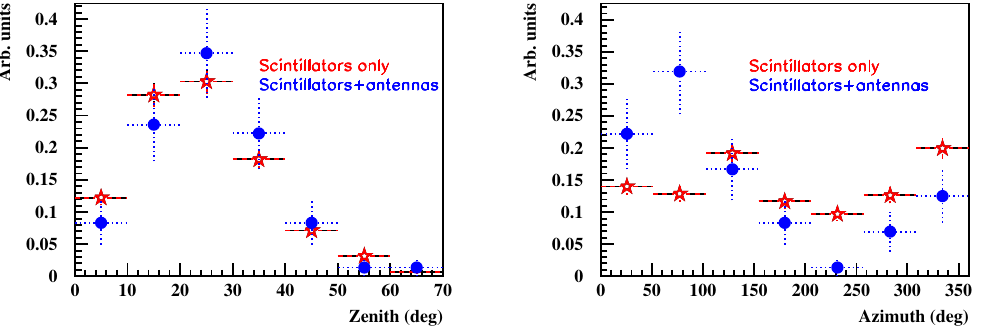
Figure 5. ( Left ) The expected (histogram) and the measured (points) distribution of the RF signal delay with respect to the latest HDM time. ( Right ) the distribution (points) of the deviation of the measured and the expected RF signal timing. The line represents the gaussian function ( µ = 1.3 ± 1.0, σ = 8.8 ± 0.8 ) that fits the distribution.